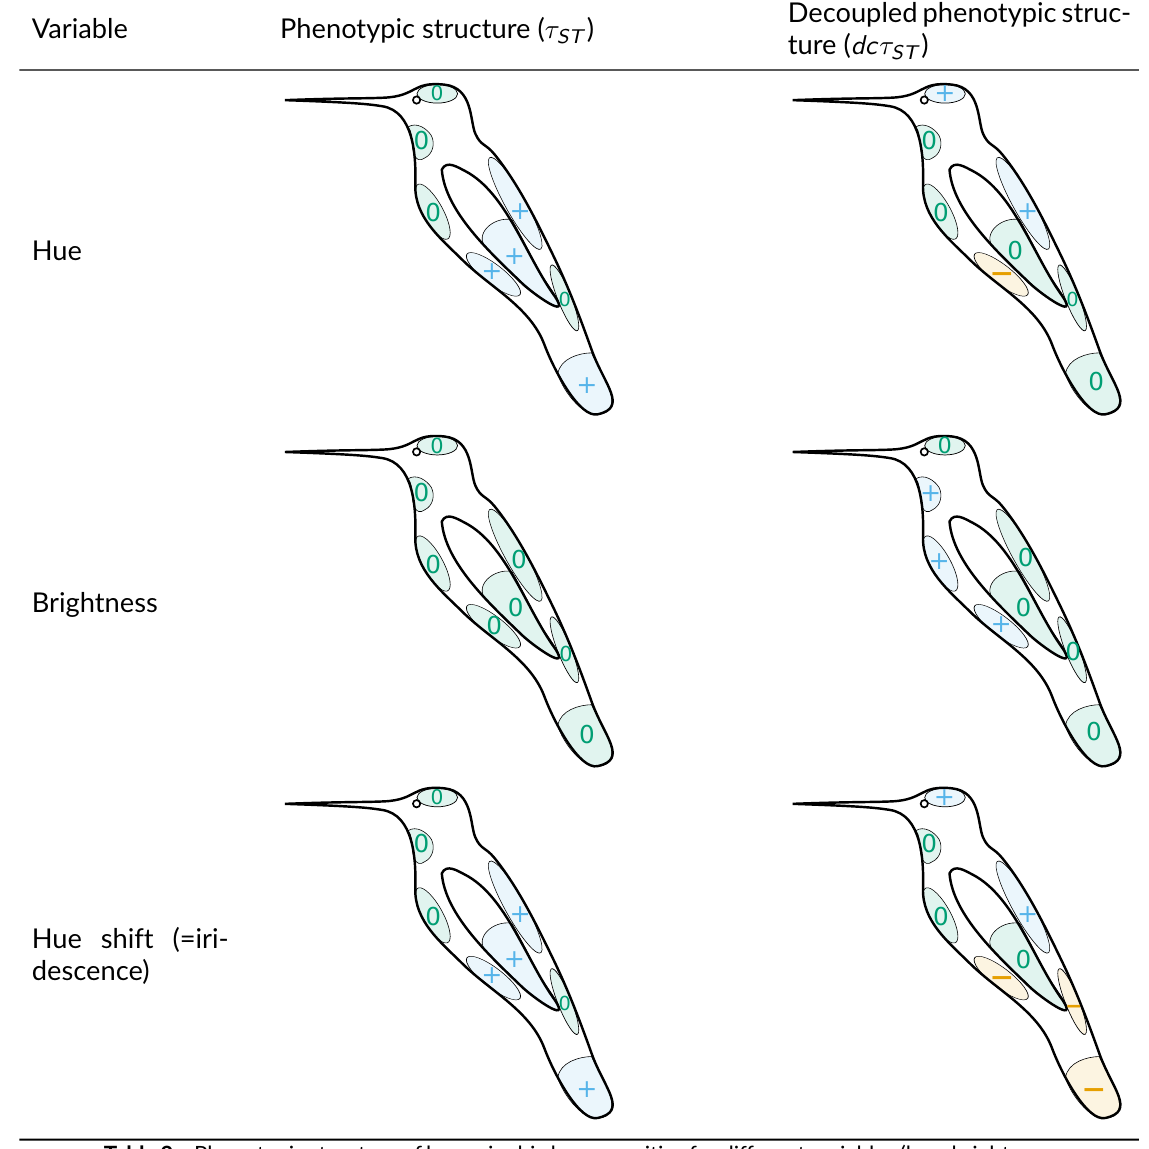
Table2 – Phenotypic structure of hummingbird communities for different variables (hue, brightness and hue shift) on the patches studied (crown, back, rump, tail, throat, breast, belly, wing; names and locations illustrated in fig. S1). Hue is a tridimensional variable defined by the reflectance spectrum position x , y and z in the tetrahedron representing avian colour space. Blue plus signs + indicate significant phenotypic clustering ( τ ST or dc τ ST > 0 ), orange minus signs − indicate significant phe- notypic overdispersion ( τ ST or dc τ ST < 0 ), and green zeros 0 represent the absence of phenotypic structure. The left column shows the raw phenotypic structure of the community (columns in ta- ble 1), which may be influenced by the phylogenetic structure while the right column shows the phenotypic structure of the community, decoupled from all effects caused by the phylogeny (rows in table 1). By comparing the values of τ ST and dc τ ST for each trait colour variable (hue, bright- ness and hue shift), we can assume a probable evolutionary scenario for each patch, based on the explanation in table 1. Exact values for the statistics are available in Supplementary